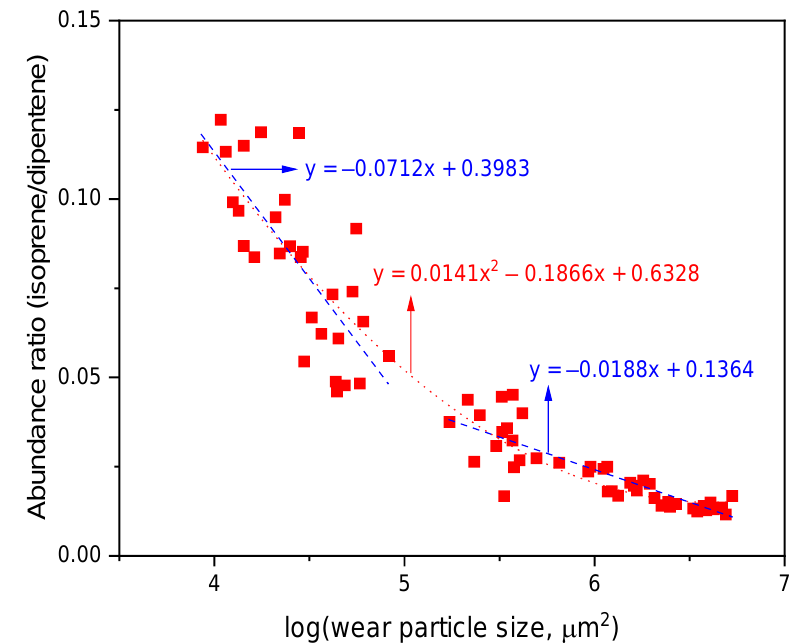
Figure 6. Variations of the isoprene/dipentene ratios of the wear particles with the logarithmic wear particle size. The wear particle size is the multiplication of the major and minor axes. All the wear particles produced from the NR0, NRth, and NRabth samples were gathered.